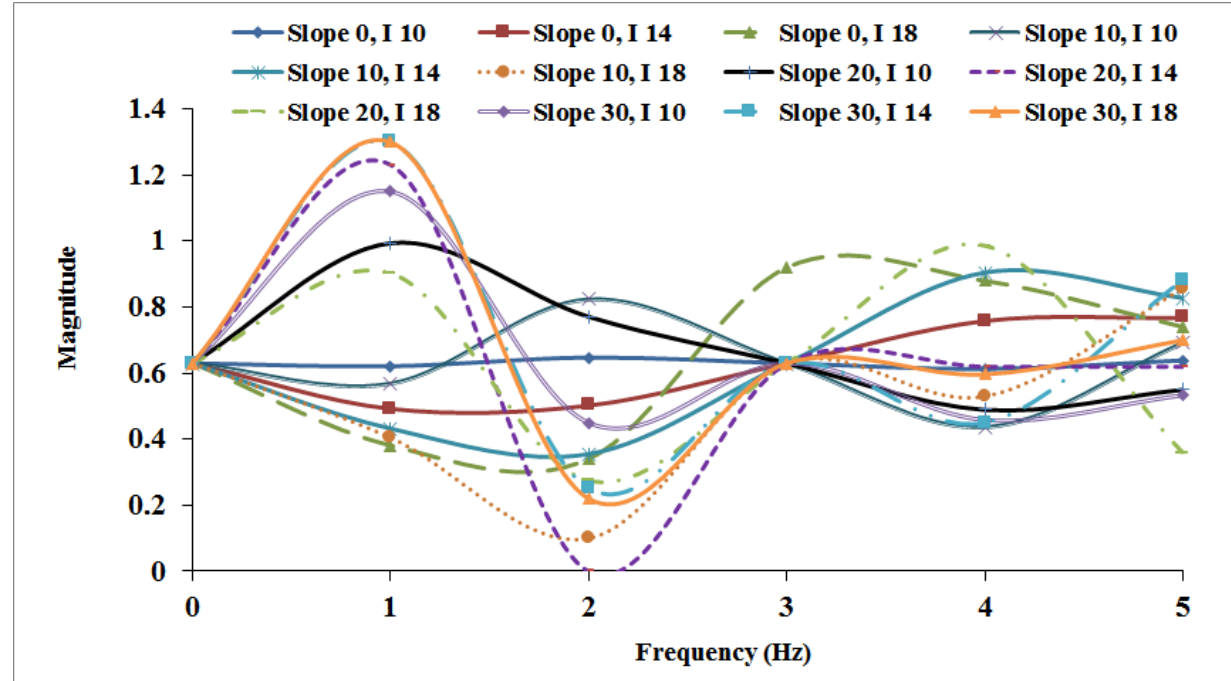
Figure 8. The graph of frequency spectrum of building surface temperature obtained from fast Fourier transform (FFT) analysis for first 120 s of the simulation for various terrain slope values and fire intensities.